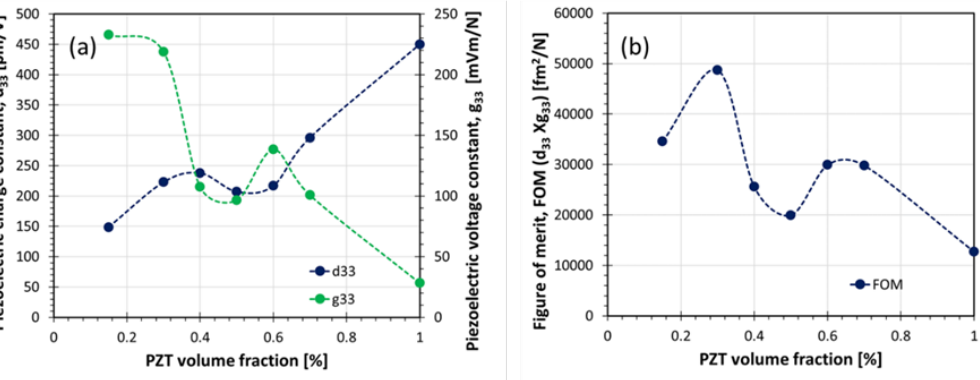
Figure 9. Electromechanical properties ( a ) piezoelectric coefficients, d 33 and g 33 and ( b ) FOM, d 33 × g 33 for PZT epoxy piezoelectric composites with 3-3 connectivity as a function of PZT volume content.